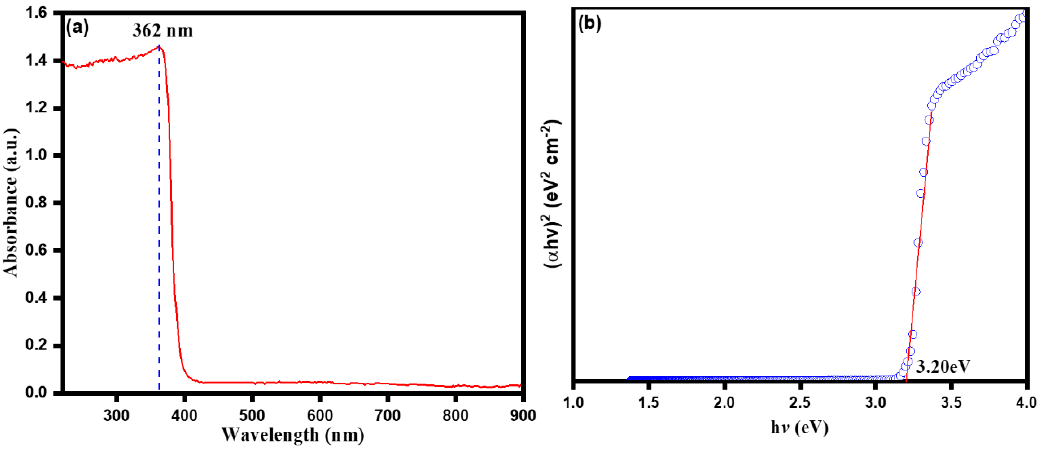
Figure 4. UV–visible DRS spectra ( a ) and bandgap energy ( b ) plot of LP-ZnO NPs.